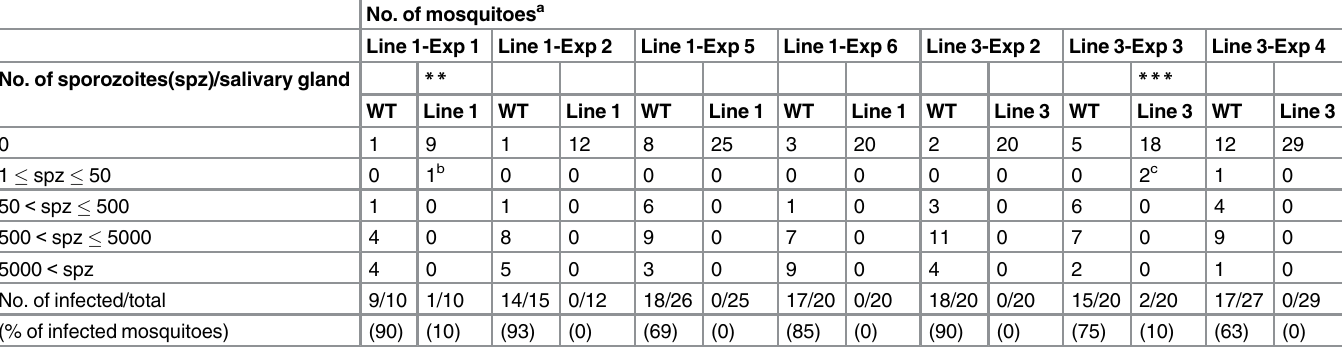
Table 1. Inhibition of infection by P . berghei sporozoites in salivary glands of transgenic mosquitoes. No. of mosquitoes a